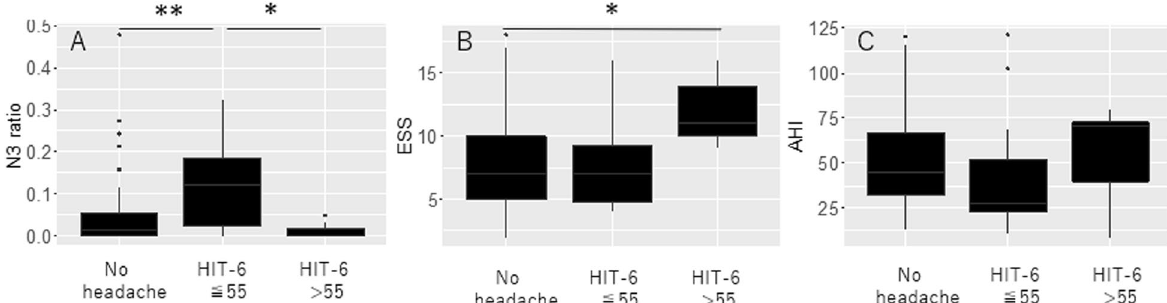
55), and relatively severe headache ≤ 8.53, df 2, p 0.014 for ESS = = =